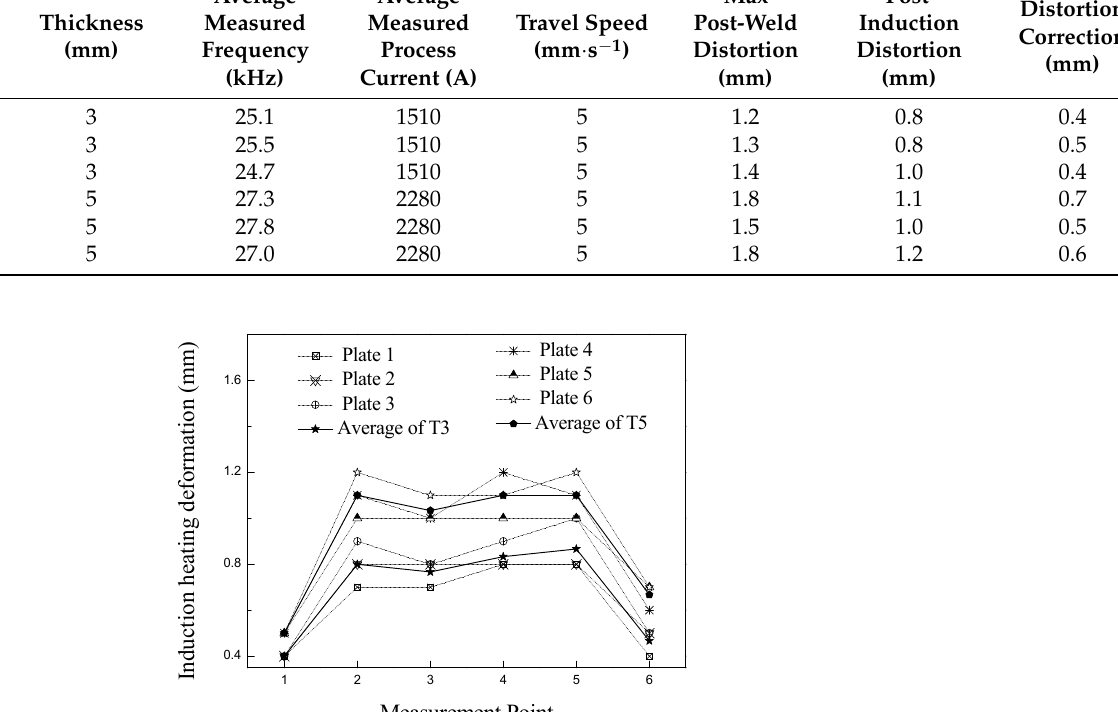
Table 4. Process parameters and rectification amount of induction heating experiment.